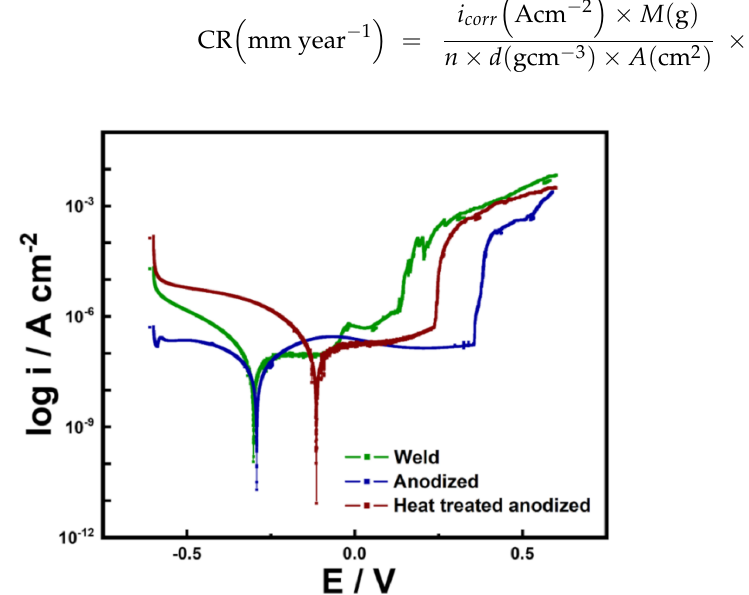
Figure 6. Potentiodynamic polarization curves of welded SS, anodized welded SS, and heat − treated anodized welded SS in artificial seawater